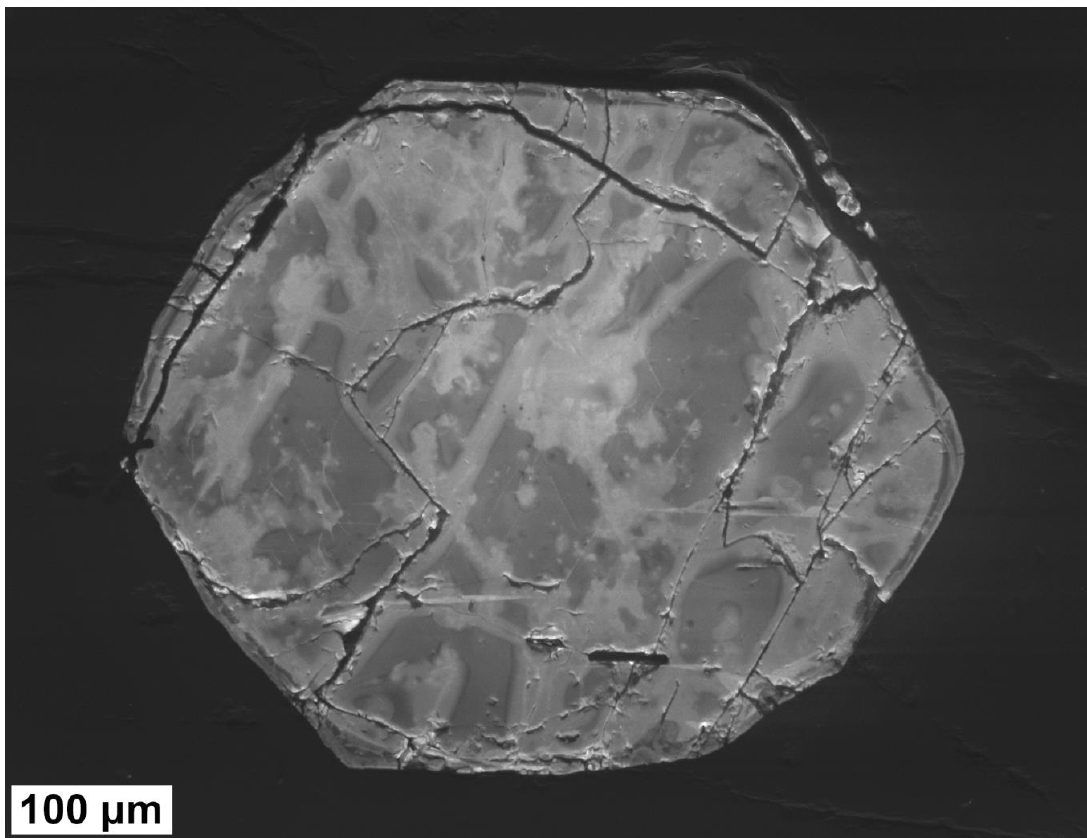
Figure 8. CL image of apatite (bright, center) wholly included within betafite demonstrating textures suggestive of fracture-controlled metasomatism. Imaged using a 15.0 KeV accelerating voltage, 10.0 mm working distance, and 120 μm aperture.